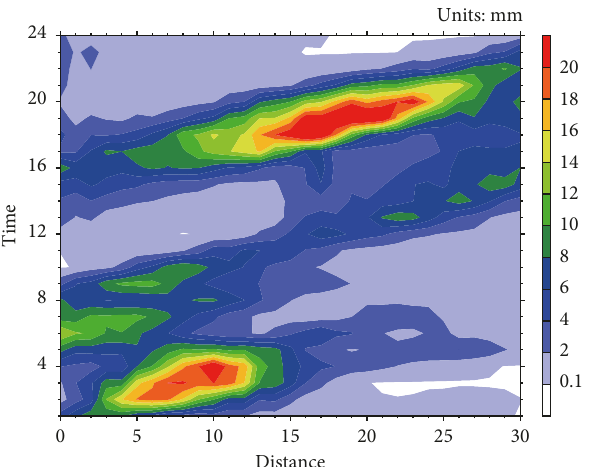
1 ) averaged over all grids along AB (shown in Figure 2(a)) in the key h · −